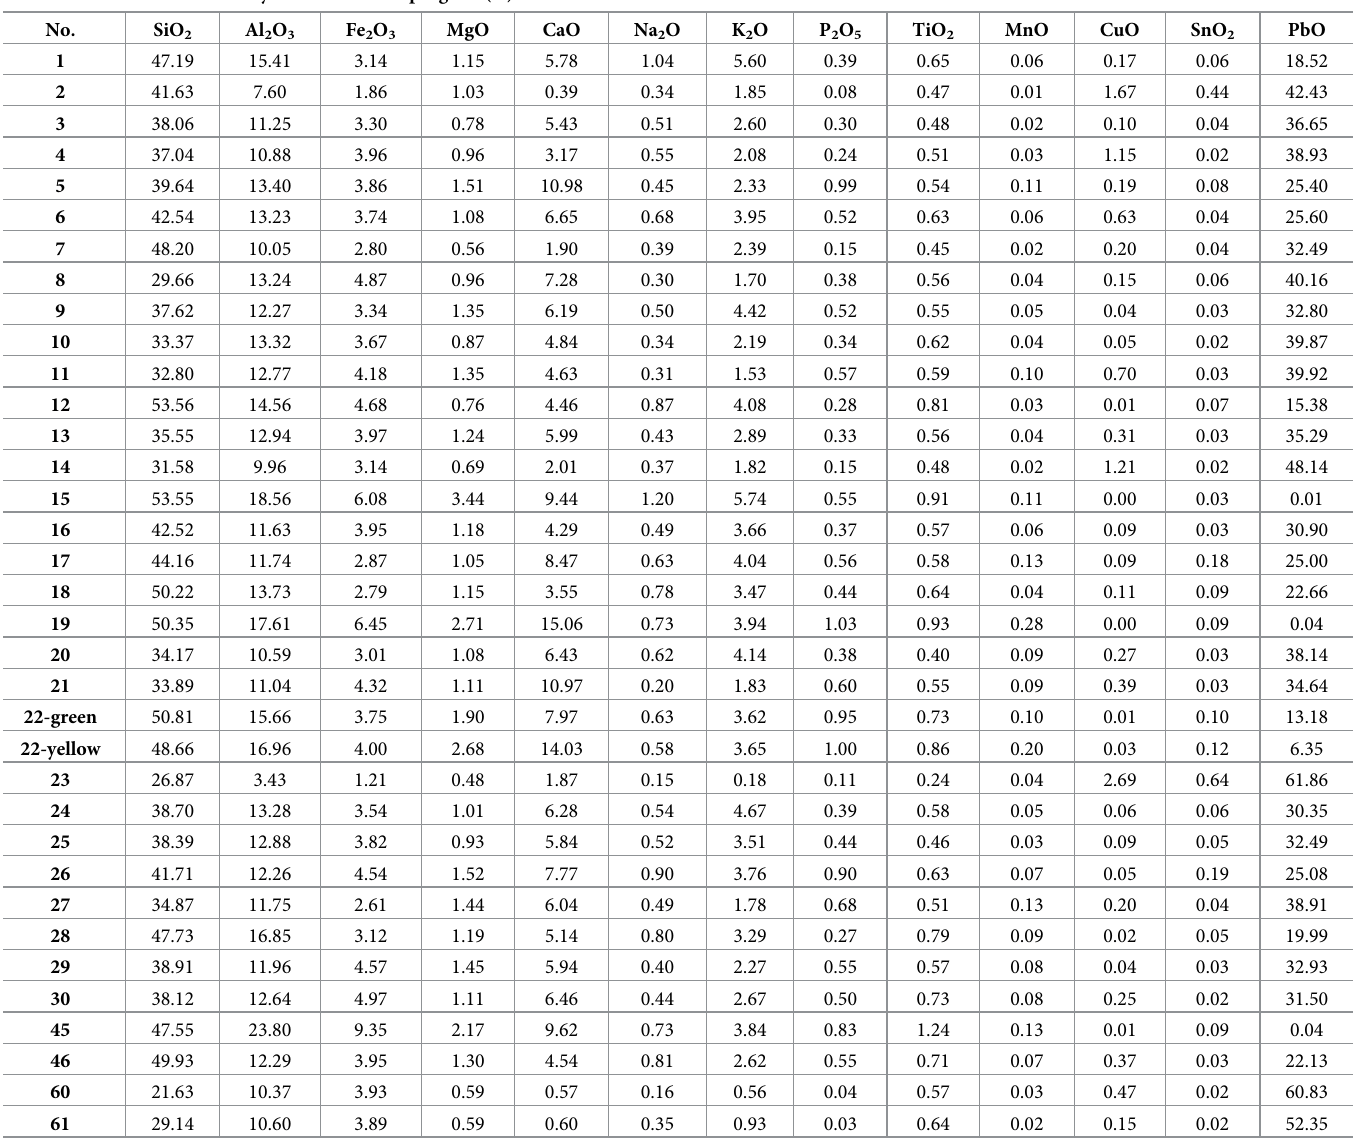
Table 2. The LA-ICP-AES analysis results of sample glaze